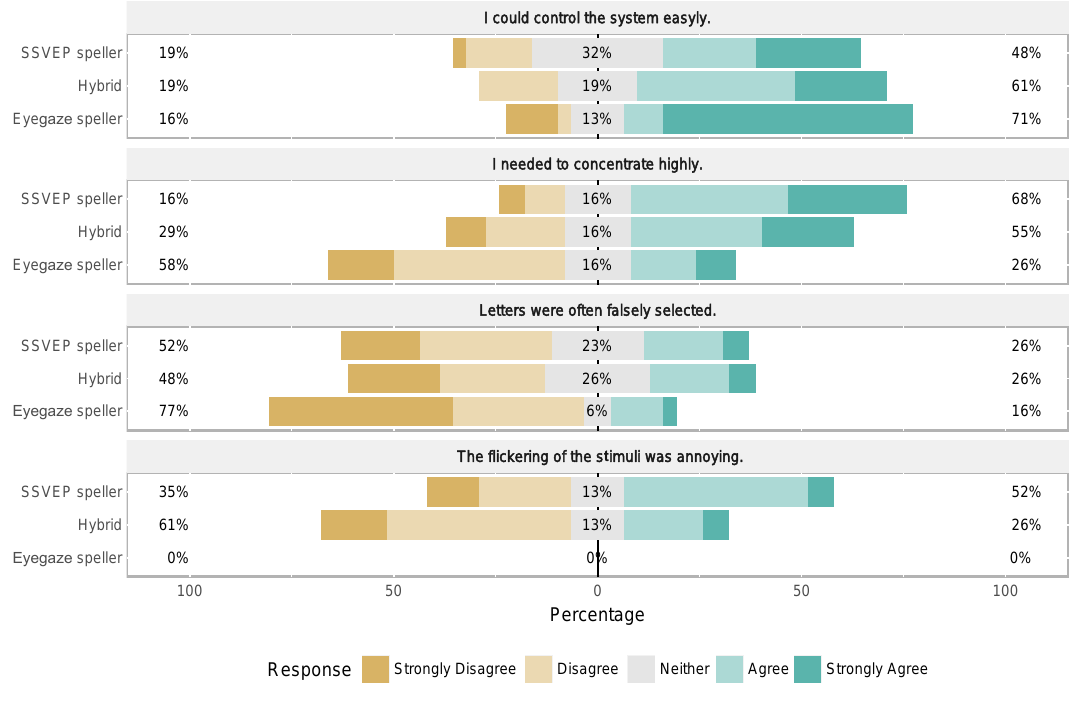
Figure 5. Results from the post test questionaire. Responses were given on a 1-5 Likert scale. The tested applications were the steady-state visual evoked potentials based application ( SSVEP speller ), the here presented Hybrid application, and the eye tracking based application ( Eyegaze speller ).